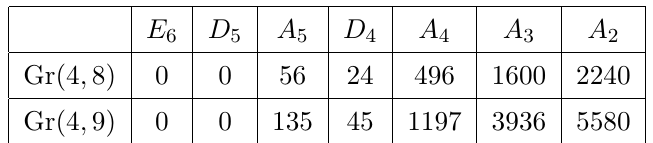
Table 1. The number of subalgebras of Gr(4 , 8) and Gr(4 , 9) of a given type that can be constructed out of the cluster X -coordinates that appear in the symbols of R (2)